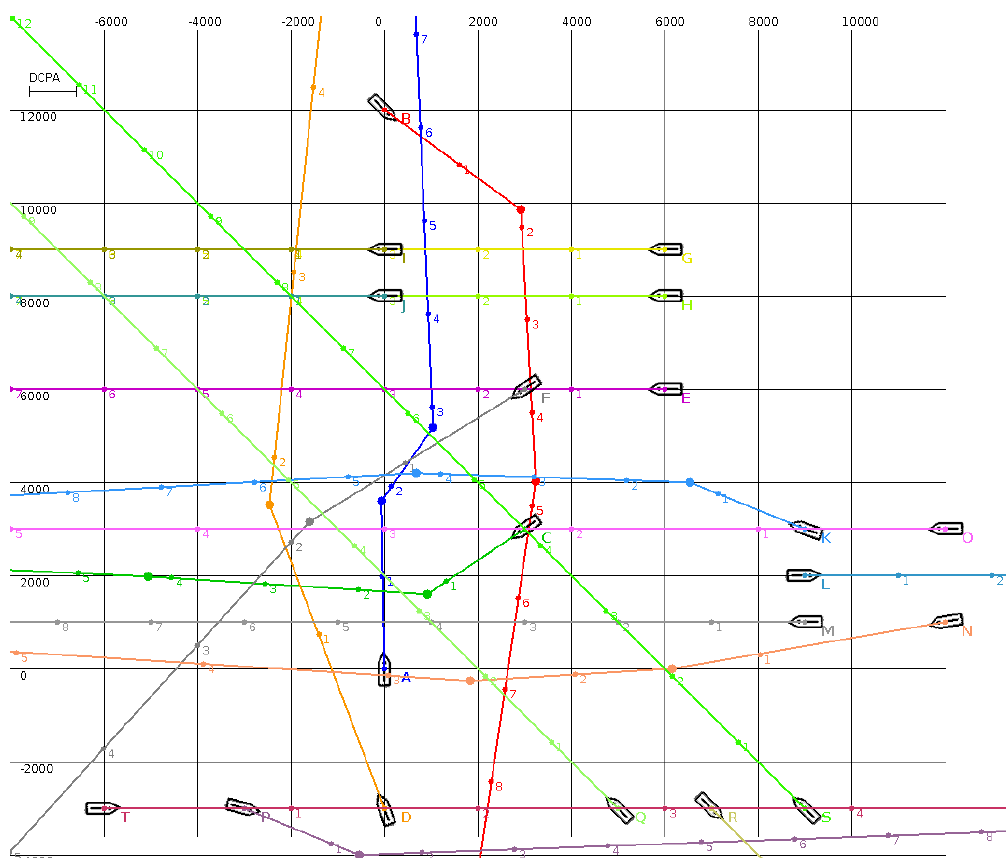
Figure 4. A multi-surface vehicle encounter involving 20 vehicles.